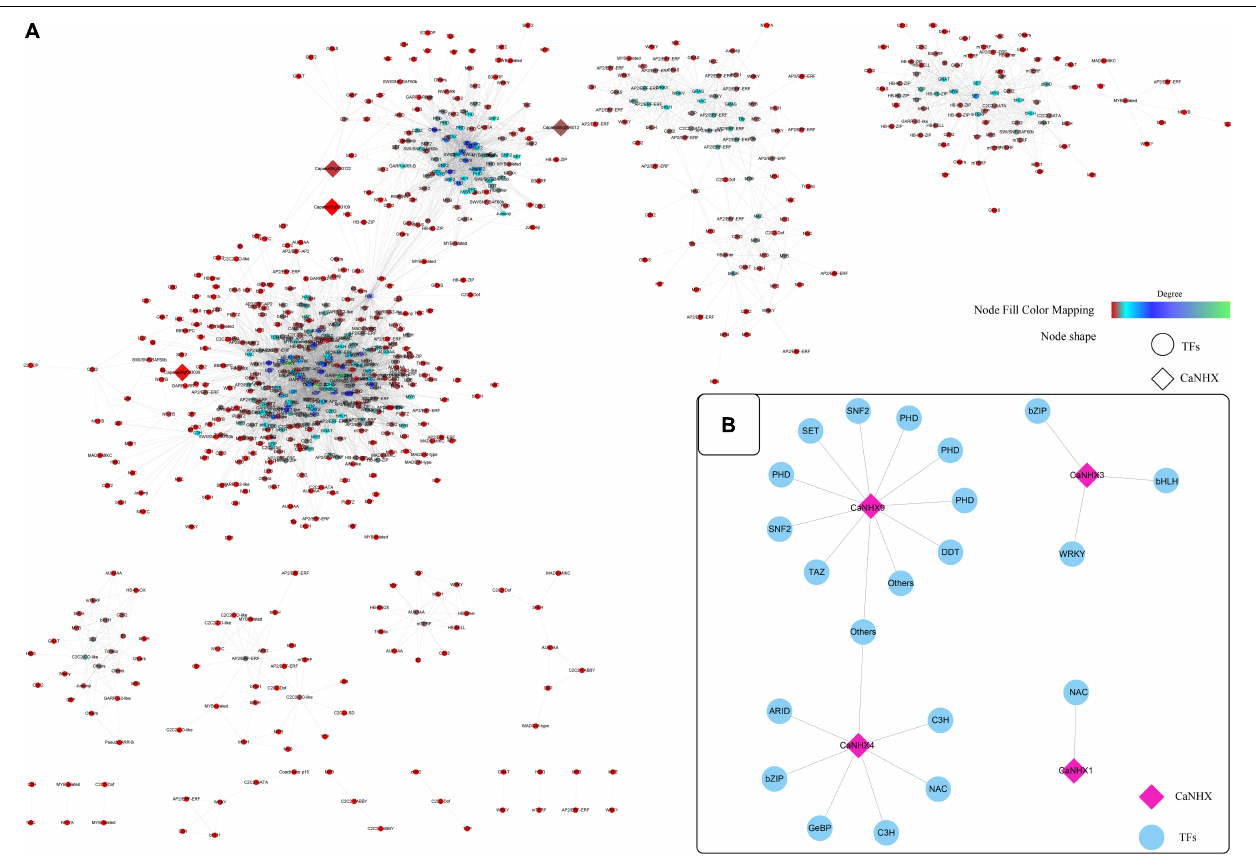
FIGURE 7 | (A,B) Co-expression network of C. annuum CaNHX gene under NaCl stress (Diamond: CaNHX genes; Circular: TFs; Node Fill Color Mapping: Degree).